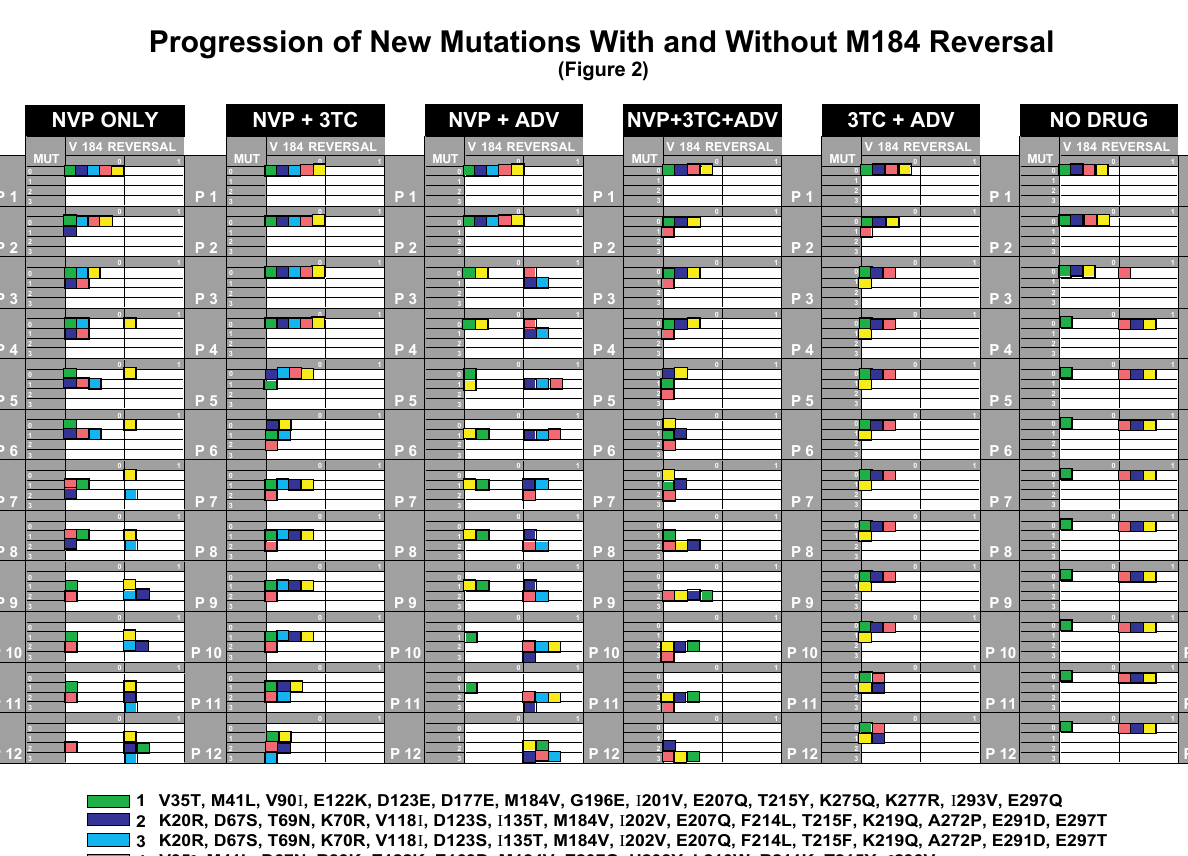
Figure 2. Progression of Mutations With and Without M184V-reversal. All mutations and M184V-reversals for every passage and isolate are